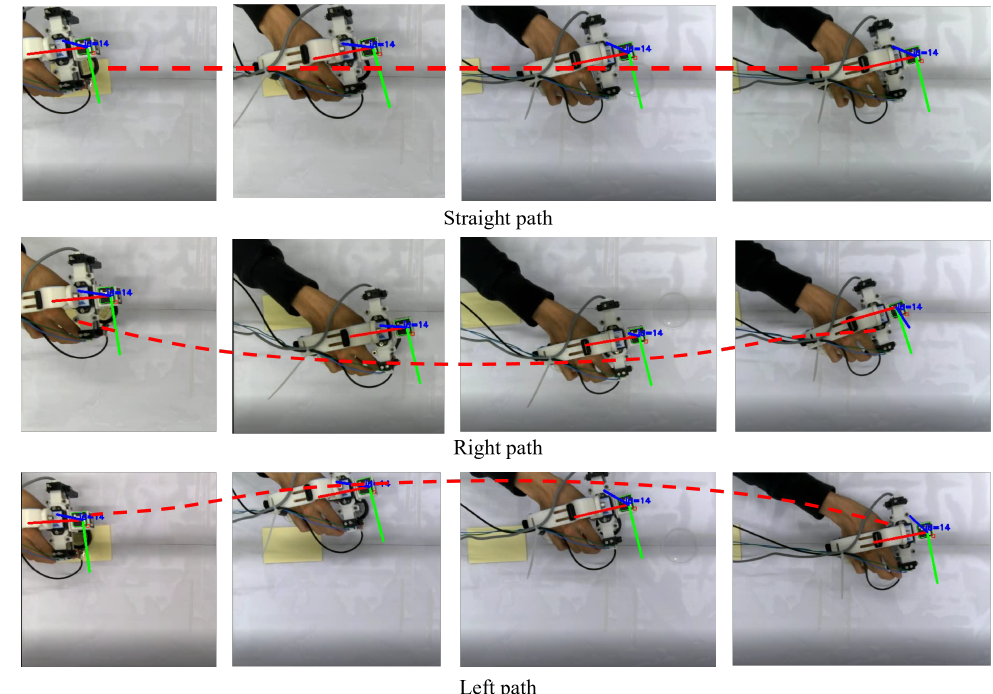
Figure 8. Three different demonstration paths (images were captured by the data collection